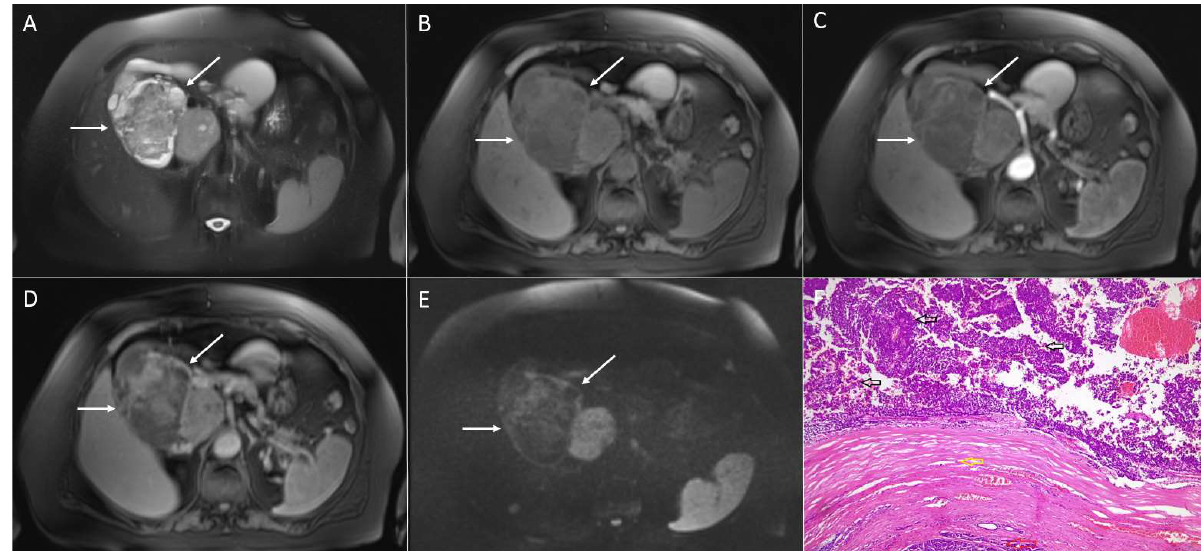
Figure 15. Neuroendocrine tumor in 55-year-old woman. Mixed solid and cystic bilobar lesion is seen in pancreatic head with heterogeneous signal intensity on T2-weighted FS image ( A ). The lesion is hypointense on T1-weighted FS image ( B ) with only slight enhancement in arterial phase ( C ) and progressive enhancement of solid portion in portal-venous phase ( D ). Solid part of the lesion displays high signal intensity on DWI ( E ). Hematoxylin and eosin (H&E) staining ( F ) showed neuroendocrine tumor ( black arrows ) with hemorrhagic foci, partly demarcated with fibro-hyalinized capsule ( yellow arrow) from normal pancreatic parenchyma ( red arrow ); original magnification ×400.